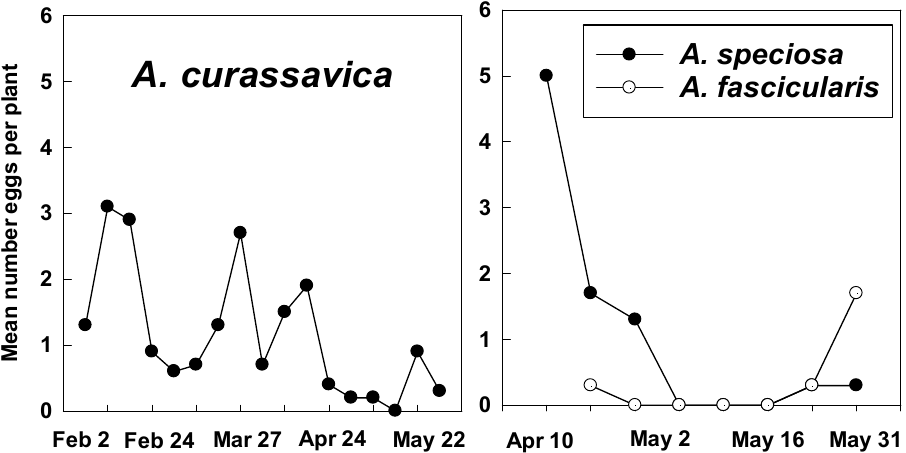
Figure 5. Monarch eggs recorded weekly on tropical milkweed ( A. curassavica ) (2 February–31 May) and native milkweeds, A. speciosa and A. fascicularis (10 April–31 May) at Googleplex, Mountain View, CA.